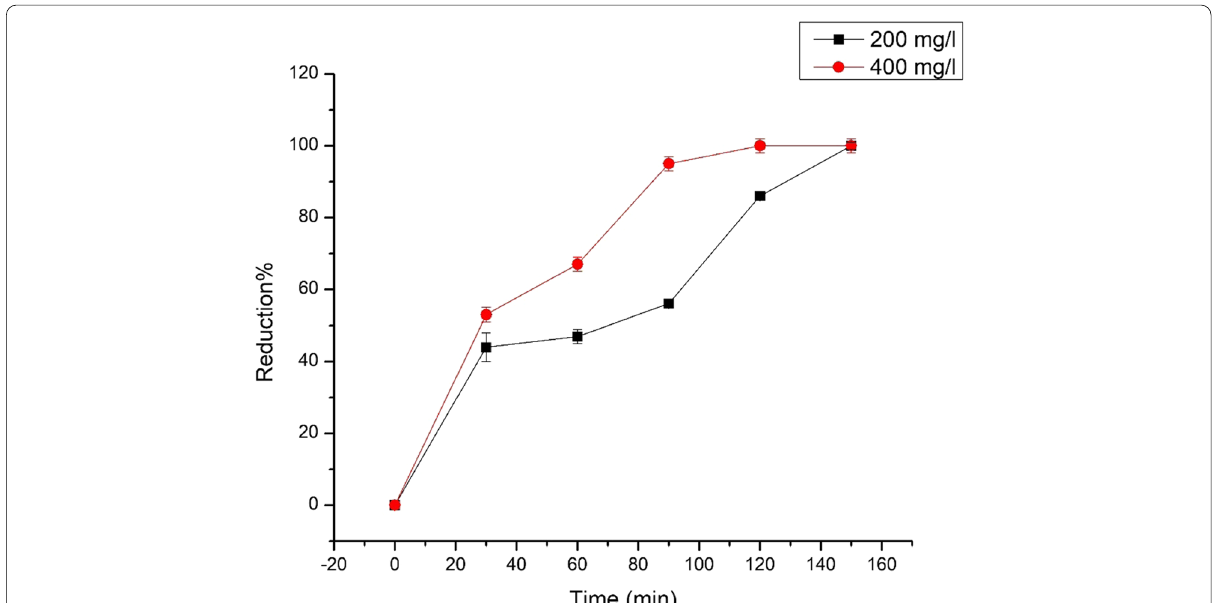
Fig. 7 Time course of the disinfection process using two different concentrations of biosynthesized Ag NPs, 200 and 400 mg/l